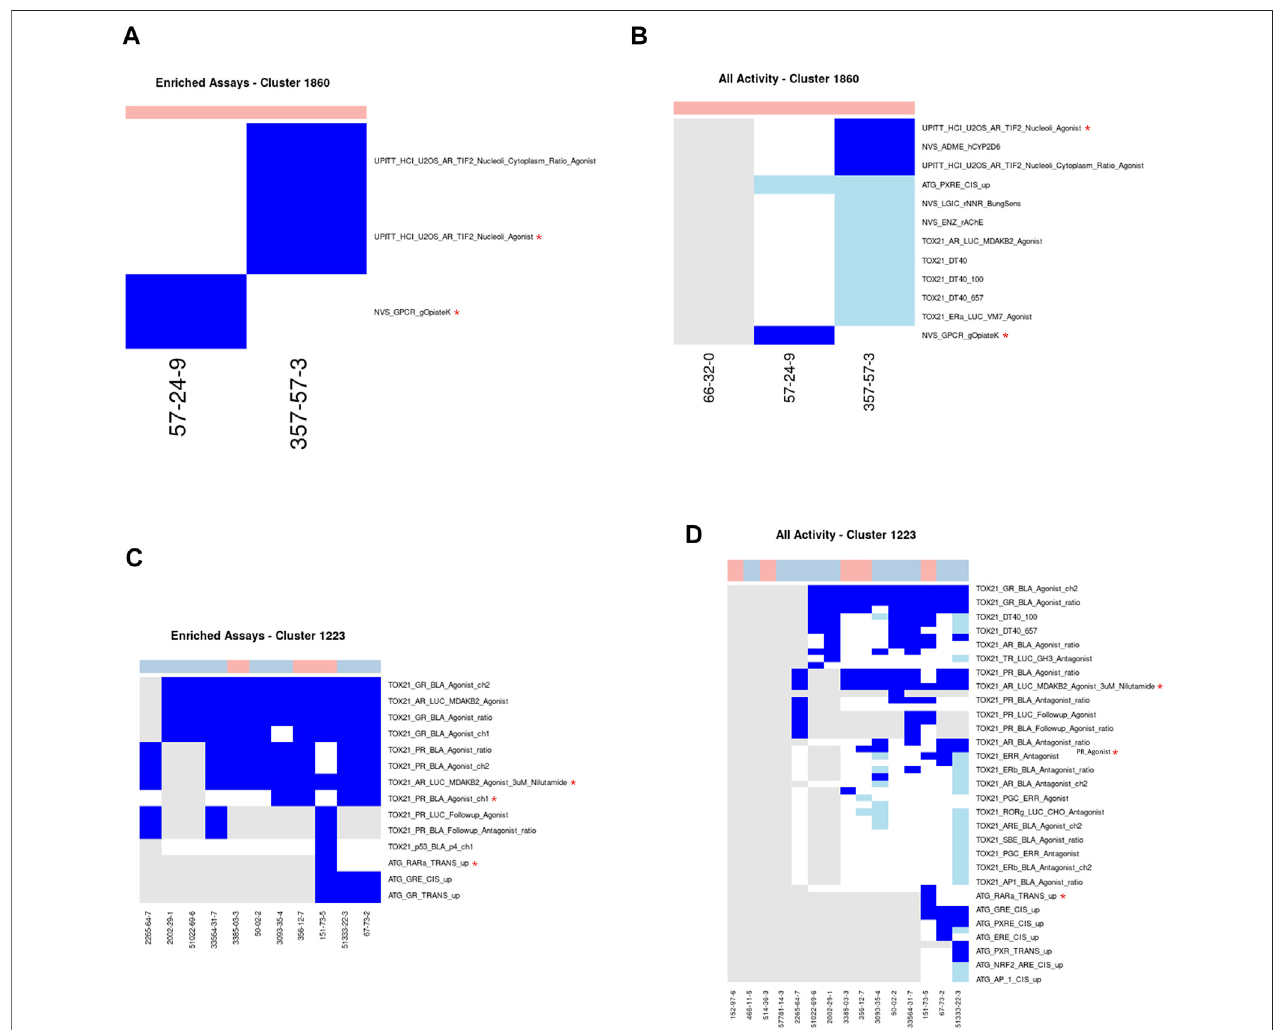
FIGURE5| Clusters 1860and 1223. A/C. Heatmap showingactivity belowthe cytotoxicity range intheassaysthatwere enriched forclusters1860 (A) and 1223. (C) Only chemicals with activity in at least one assay are shown. B/D. Heatmap showing activity for all assays where at least one chemical from the clusters 1860 (B) or 1223 (D) wasactive.Heatmapcolors:blue=activebelowthecytotoxicitypoint,lightblue=activeabovethecytotoxicitypoint, white=inactive, grey=nottested.Topof heatmap: red = toxic, blue = nontoxic, aquamarine = unde fi ned. Red asterisks identify the assay(s) selected for that cluster.